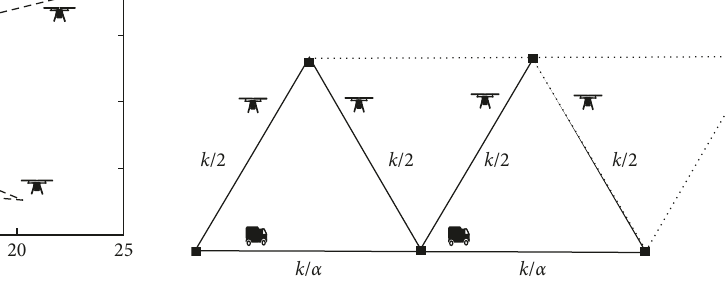
Figure 3: Practical best case